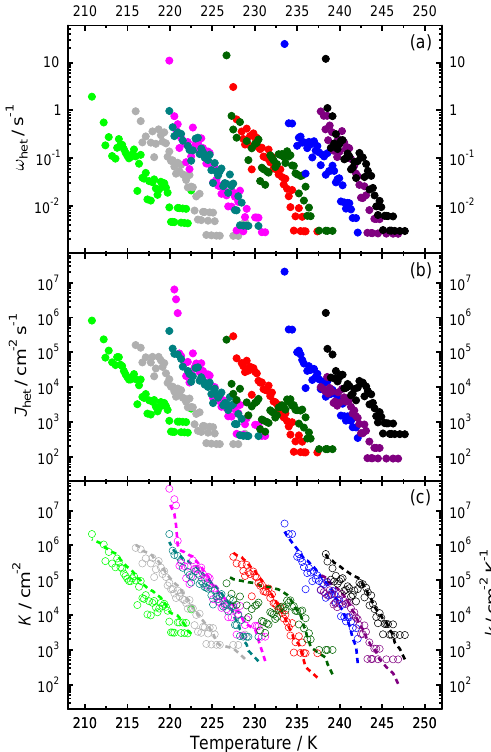
Fig. 8. Experimentally derived (a) heterogeneous ice nucleation rates, ω het , (b) heterogeneous ice nucleation rate coefficients, J het , and (c) differential and cumulative nuclei spectra, k(T ) and K(T ) , respectively, for aqueous NaCl/diatom droplets shown as a function of T and a w . In (c) , the k(T ) and K(T ) are given as open circles and dotted lines, respectively. Black, purple, blue, green, red, teal, magenta, gray, and lime colors correspond to aqueous NaCl droplets containing diatoms with initial a w of 0.984, 0.969, 0.951, 0.926, 0.902, 0.873, 0.850, 0.826,